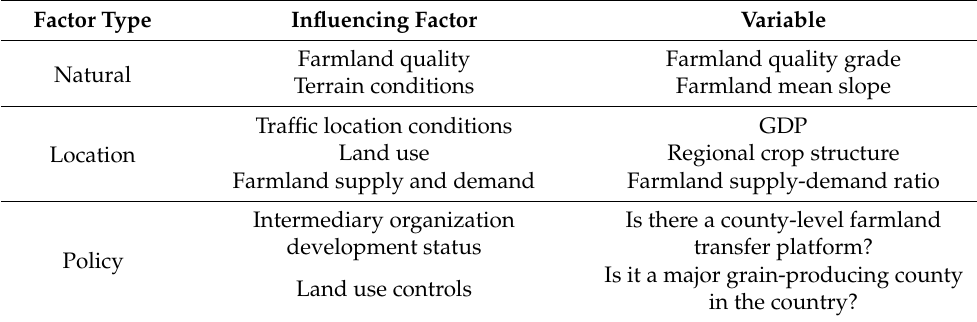
Table 1. Index system of factors affecting farmland transfer